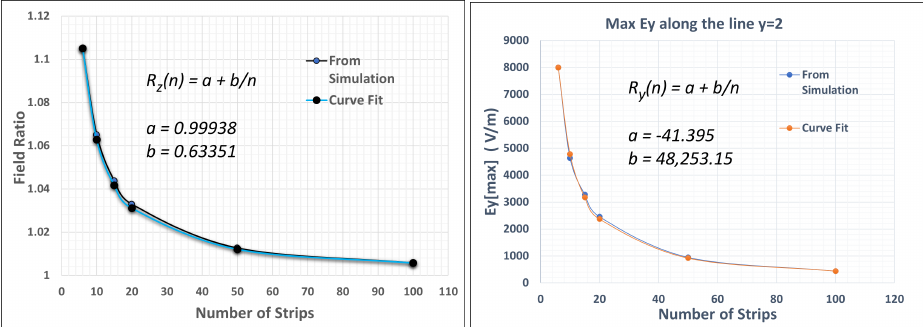
Figure 10. ( Left ): Uniformity of the field, E z , on the central axis as a function of the number of voltage strips. ( Right ): Value of R y ( max ) measured at y = 2 m as a function of the number of voltage